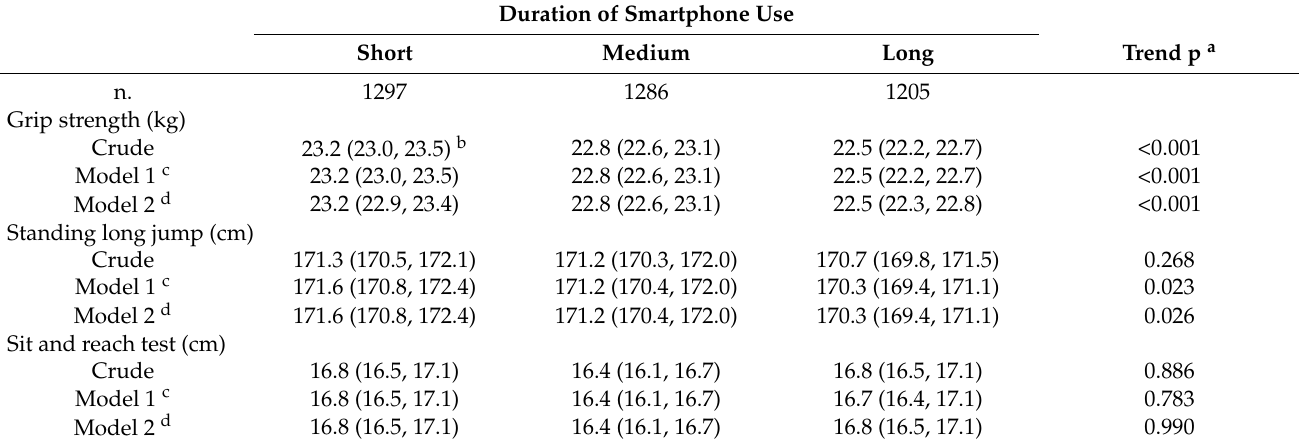
Table 4. Adjusted relationship between duration of smartphone use and physical fitness in female